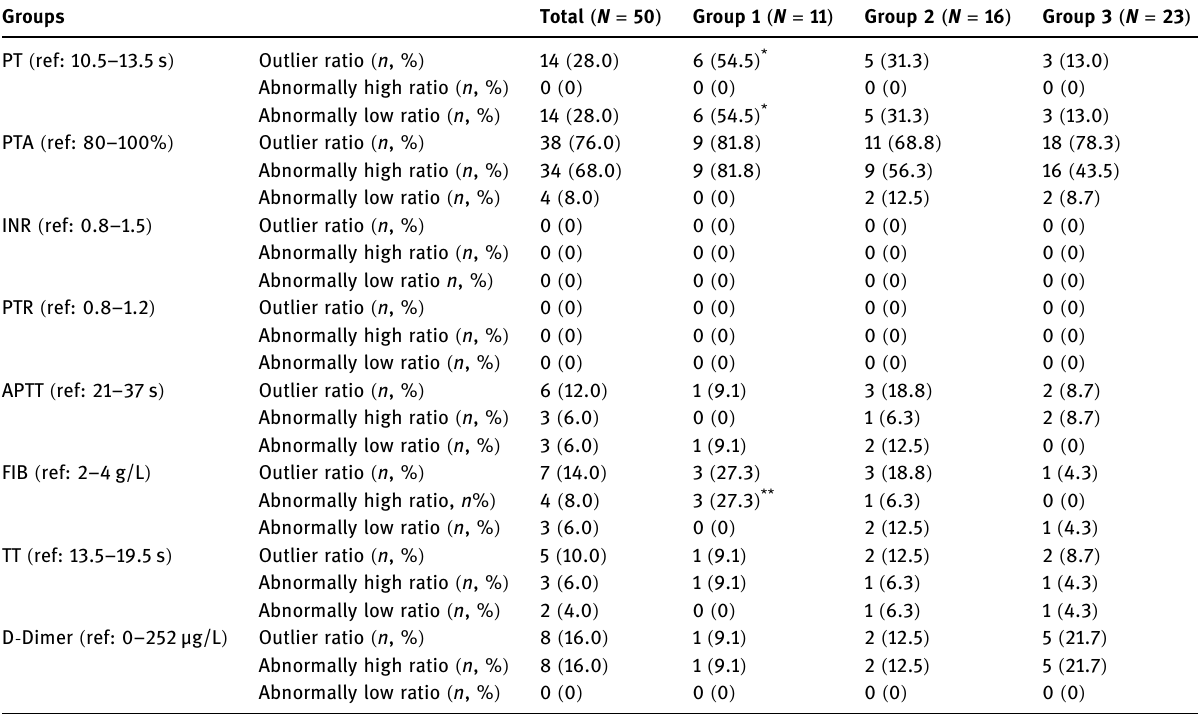
Table 7: Outlier comparison of coagulation factors